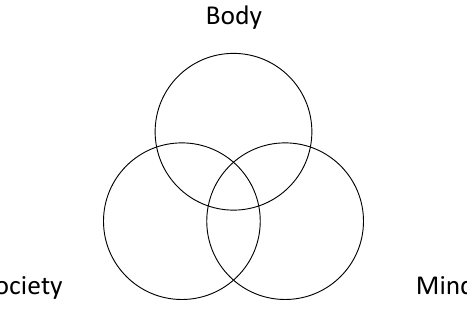
Figure 1 . The systemic approach to peace after Bateson (Source: Dietrich, 2013, p.